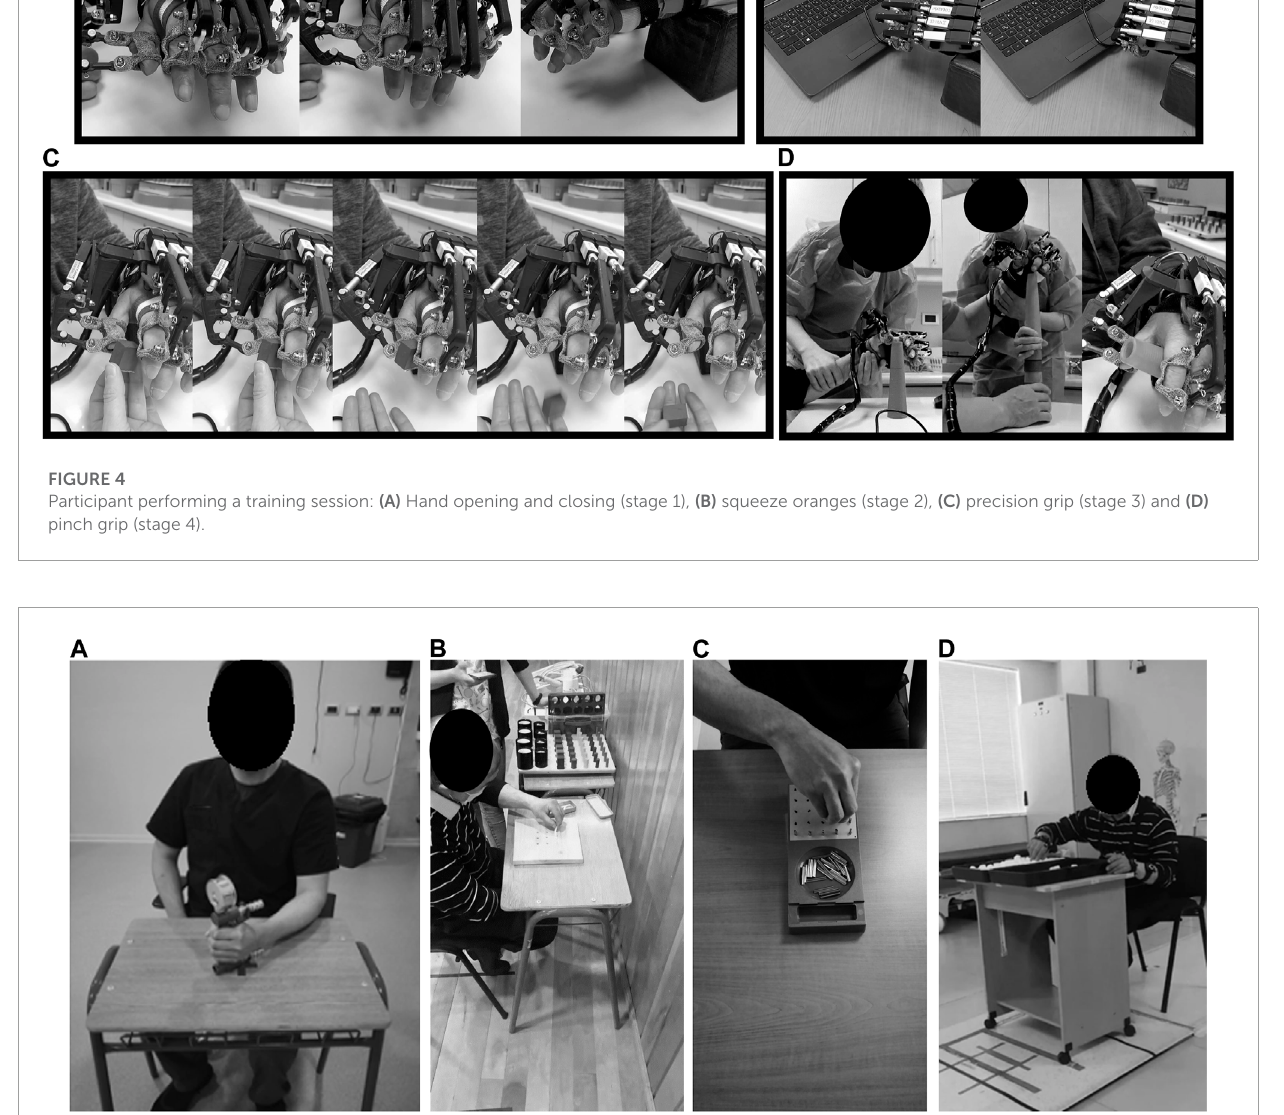
(Ong et al., 2017). Grip measurements were repeated three times and the average value is